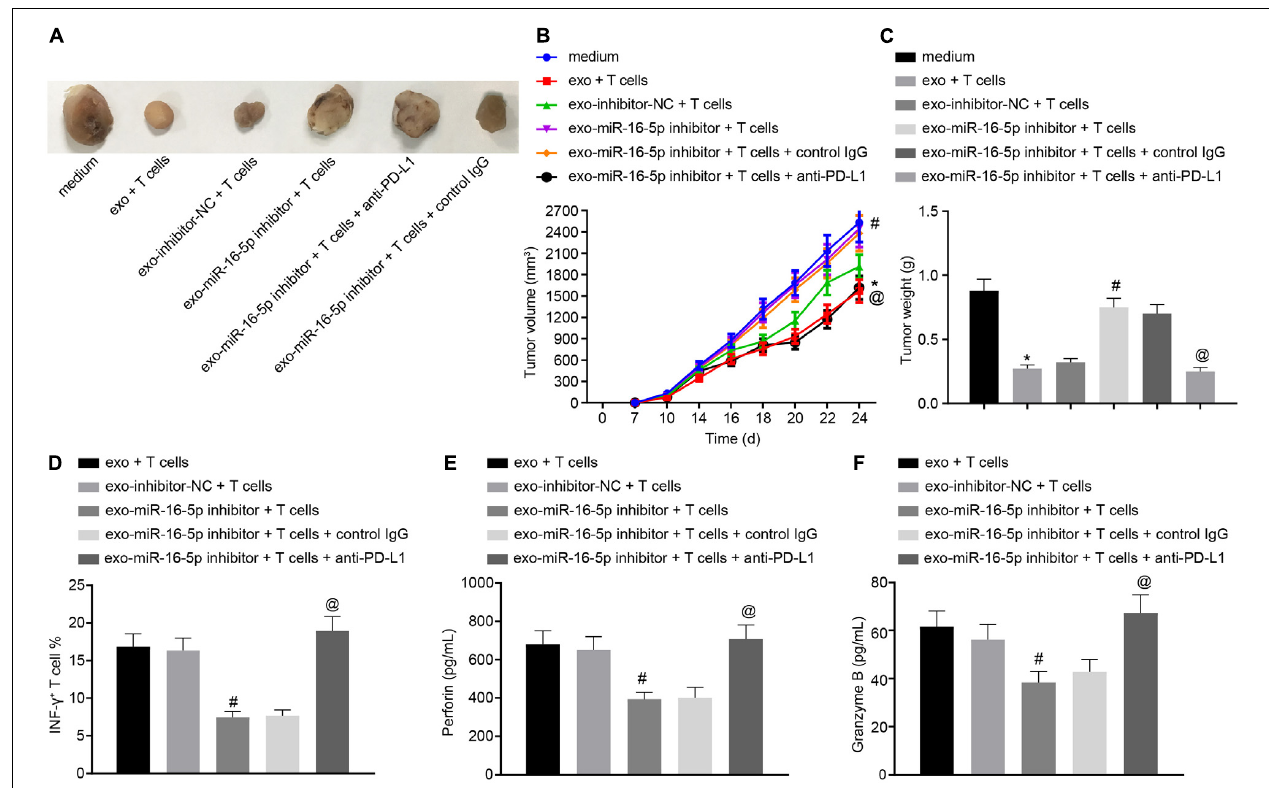
FIGURE 6 | M1 macrophage-secreted exosomes containing miR-16-5p impair anti-tumor immune response and tumor formation in vivo by down-regulating PD-L1. The mice were injected with GC cells (5 × 10 6 cells per mouse) and T cells (1 × 10 6 cells per mouse) for 24-h incubation. (A) Tumor morphology in mice ( n = 5). (B) Tumor volume in mice ( n = 5). (C) Tumor weight in mice ( n = 5). (D) Flow cytometry of activated INF- γ + T cells in the spleen cells. (E) EILSA of the expression of perforin in lysis buffer of the spleen cells ( n = 5). (F) EILSA of the expression of granzyme B in lysis buffer of the spleen cells ( n = 5). * p < 0.05 compared with the treatment of medium; # p < 0.05 compared with the treatment of exo-inhibitor-NC + T cells. @ p < 0.05 compared with the treatment of exo-miR-16-5p inhibitor + T cells + Control IgG or exo-miR-16-5p inhibitor + T cells. Measurement data is representative of three independently performed experiments and expressed as the mean ± standard deviation. Comparisons among multiple groups are analyzed by one-way ANOVA with Tukey’s post hoc test. Data comparisons at various time points are analyzed by repeated measures ANOVA with Bonferroni’s post hoc test. n =